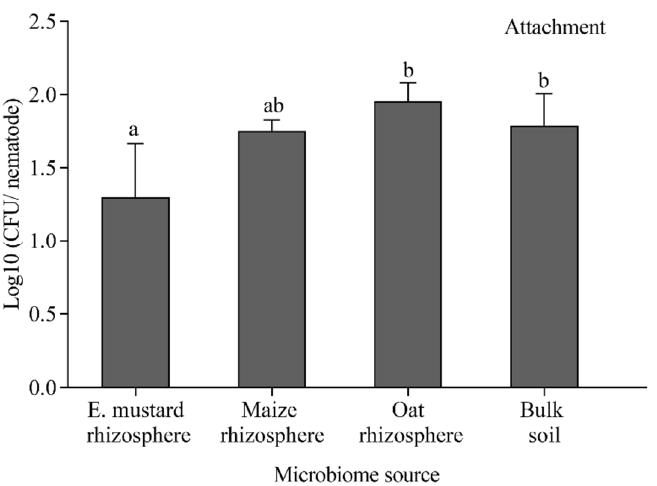
Figure 6. Number of microbes attached to infective stages of Pratylenchus penetrans after baiting in suspensions of soil from the rhizosphere of different crops or the corresponding bulk soil. Letters above bars indicate significant differences among treatments (Tukey’s test, p < 0.05, n = 12). Error bars represent standard deviations. E. mustard: Ethiopian mustard.